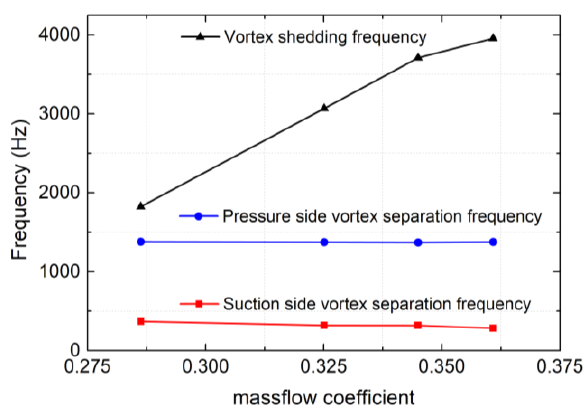
Figure 8. Variation of inherent frequencies with mass flow.